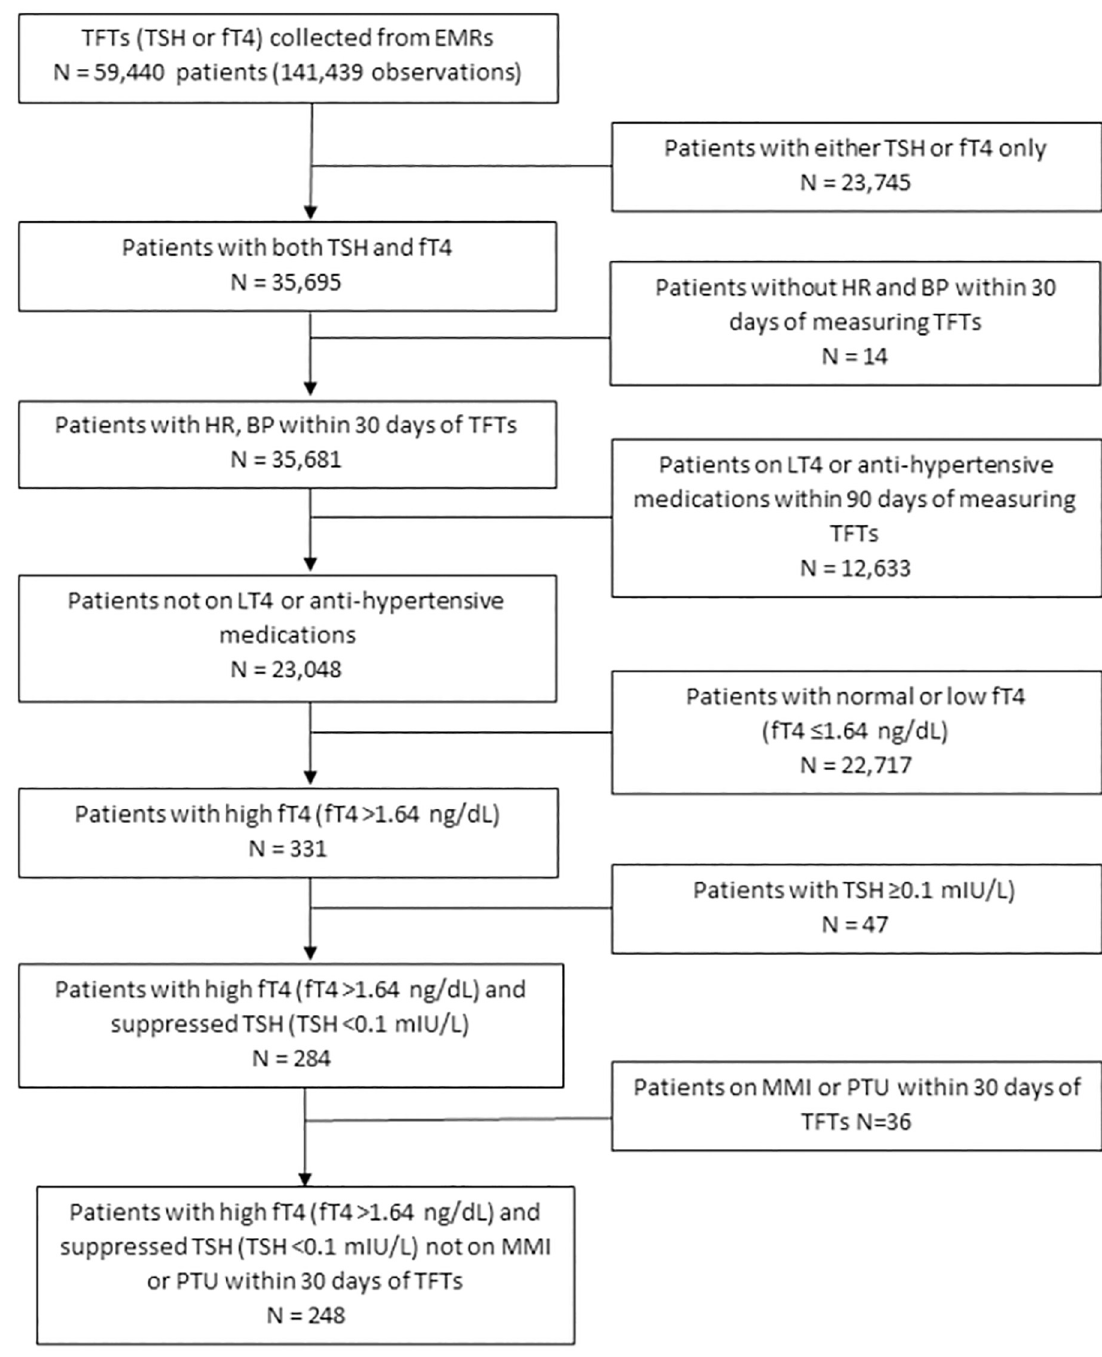
Fig 1. Flow chart for inclusion and exclusion of the study population with